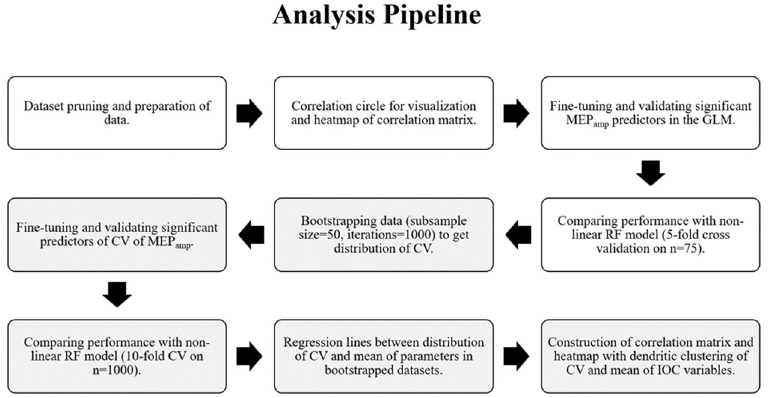
Figure 2. Flowchart of data analysis pipeline. (MEP amp = MEP amplitude at 120% resting motor threshold, GLM = General Linear Model, CV = Coefficient of Variation, RF = Random Forest, IOC = Input–Output Curve.).